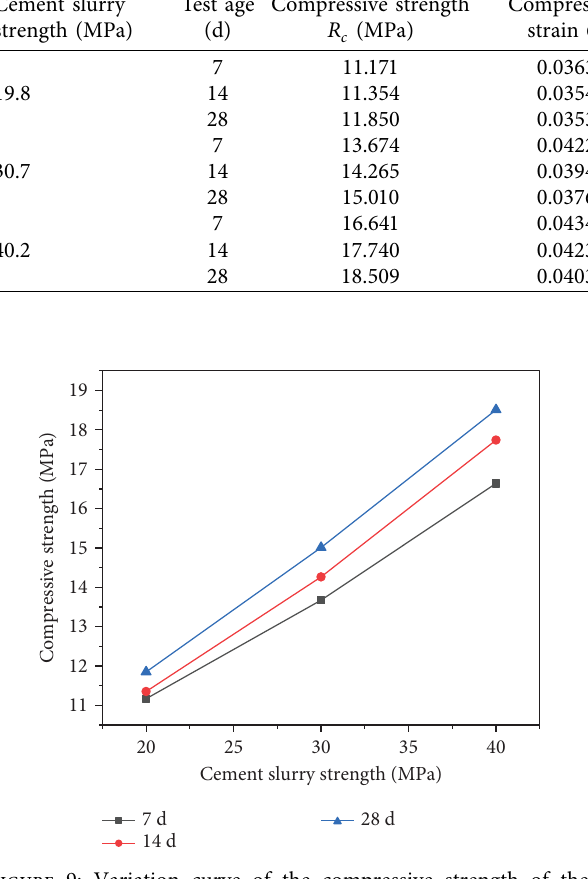
Figure 9: Variation curve of the compressive strength of the prismatic specimen with the strength of the cement slurry.